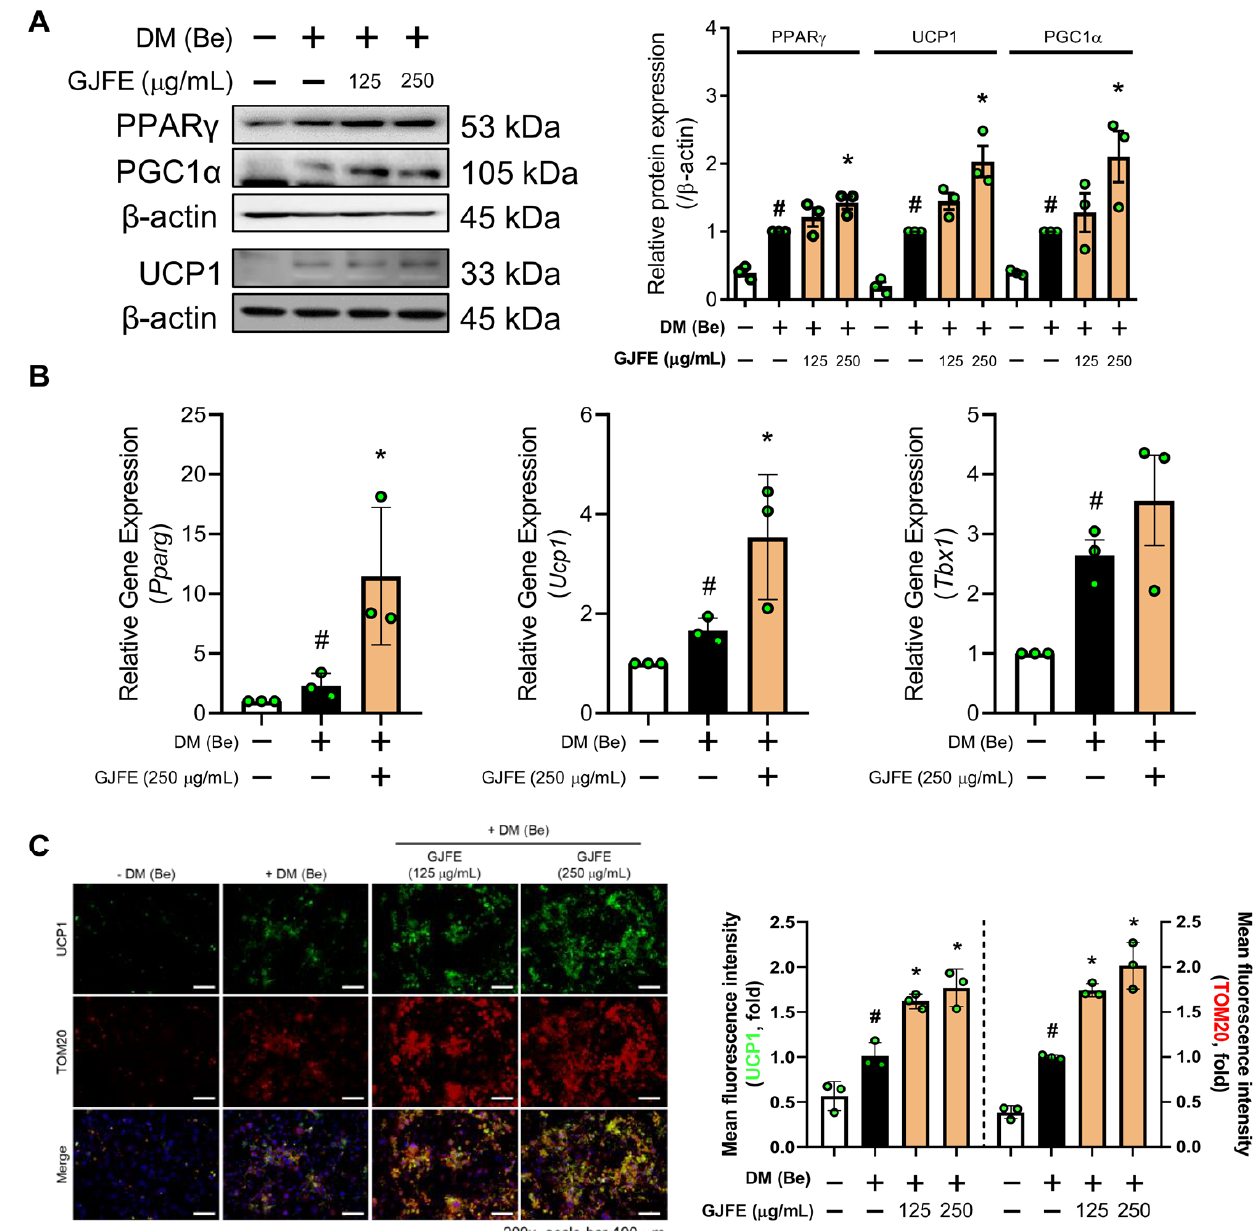
Figure 3. Effect of GJFE on thermogenic markers in beige-induced 3T3-L1 cells. ( A ) Protein levels of PPAR γ , PGC1 α , and UCP1 were analyzed by Western blot analysis in beige-induced 3T3-L1 cells treated with GJFE (125 and 250 µ g/mL). ( B ) mRNA expression of Ucp1 , Pparg , and Tbx1 in beige adipocytes was measured by RT-PCR analysis and normalized by Gapdh . ( C ) The expression of UCP1 (green), TOM20 (red), and DAPI (blue) were detected by immunofluorescence staining (magnification 400 × , scale bar 75 µ m). β -actin was used as a loading control for Western blot analysis. All data are expressed as the mean ± SEM of the data from three or more separate experiments. # p < 0.05 vs. DM (Be)-untreated 3T3-L1 cells, * p < 0.05 vs. DM (Be)-treated 3T3-L1 cells. GJFE, Gardenia jasminoides fruit